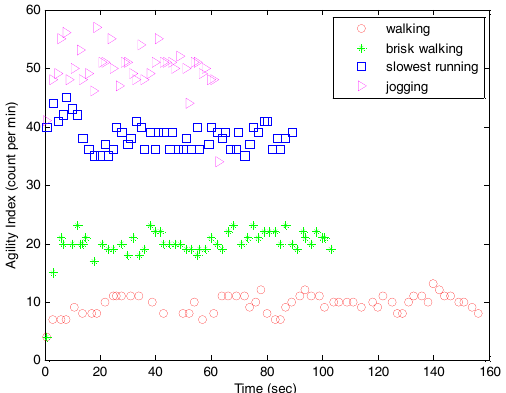
Figure 14. Agility index monitoring during normal walking, brisk walking, slowest running, and jogging in an open field test.